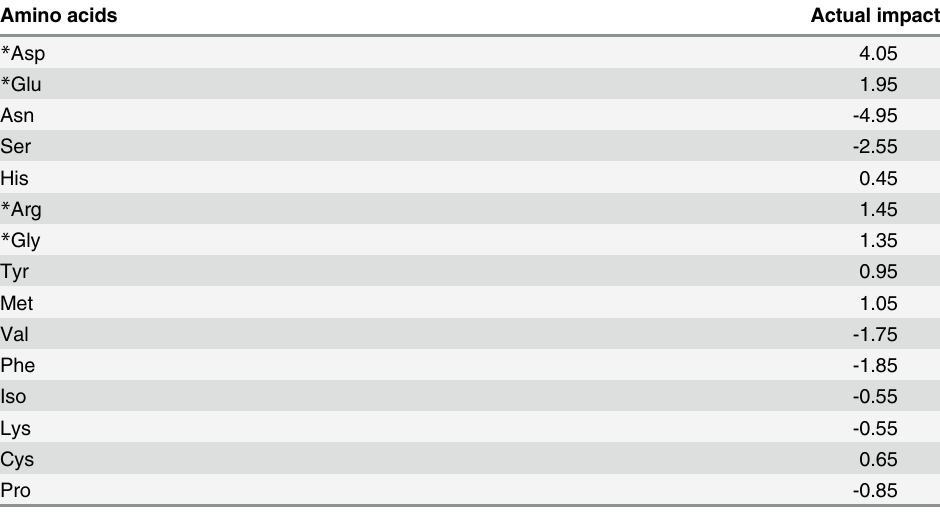
Pro * Amino acids in bold were selected for further optimization by